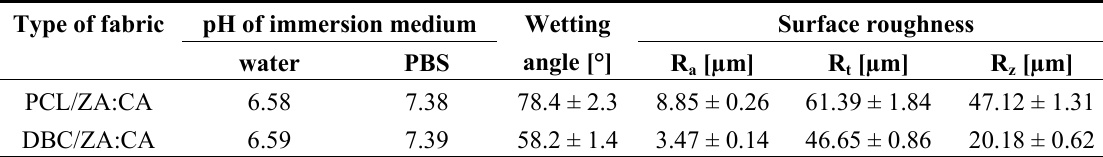
Table 5. Physicochemical properties of fibrous